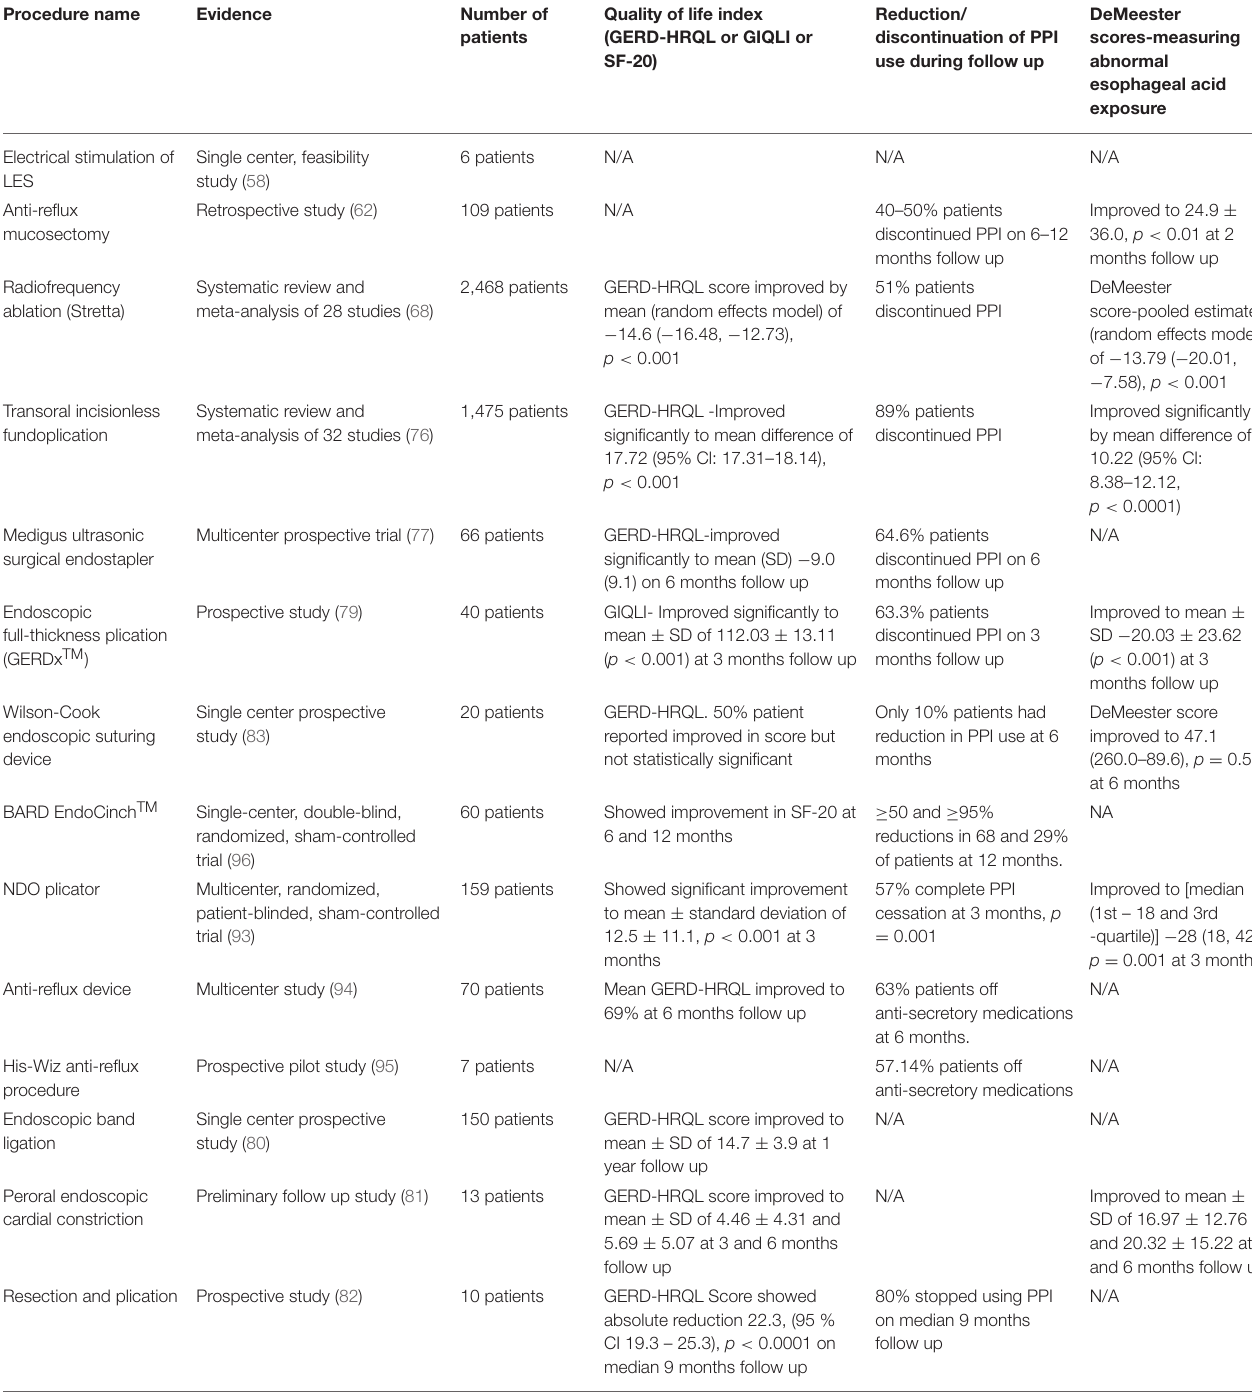
TABLE 4 | Endoscopic procedure for GERD